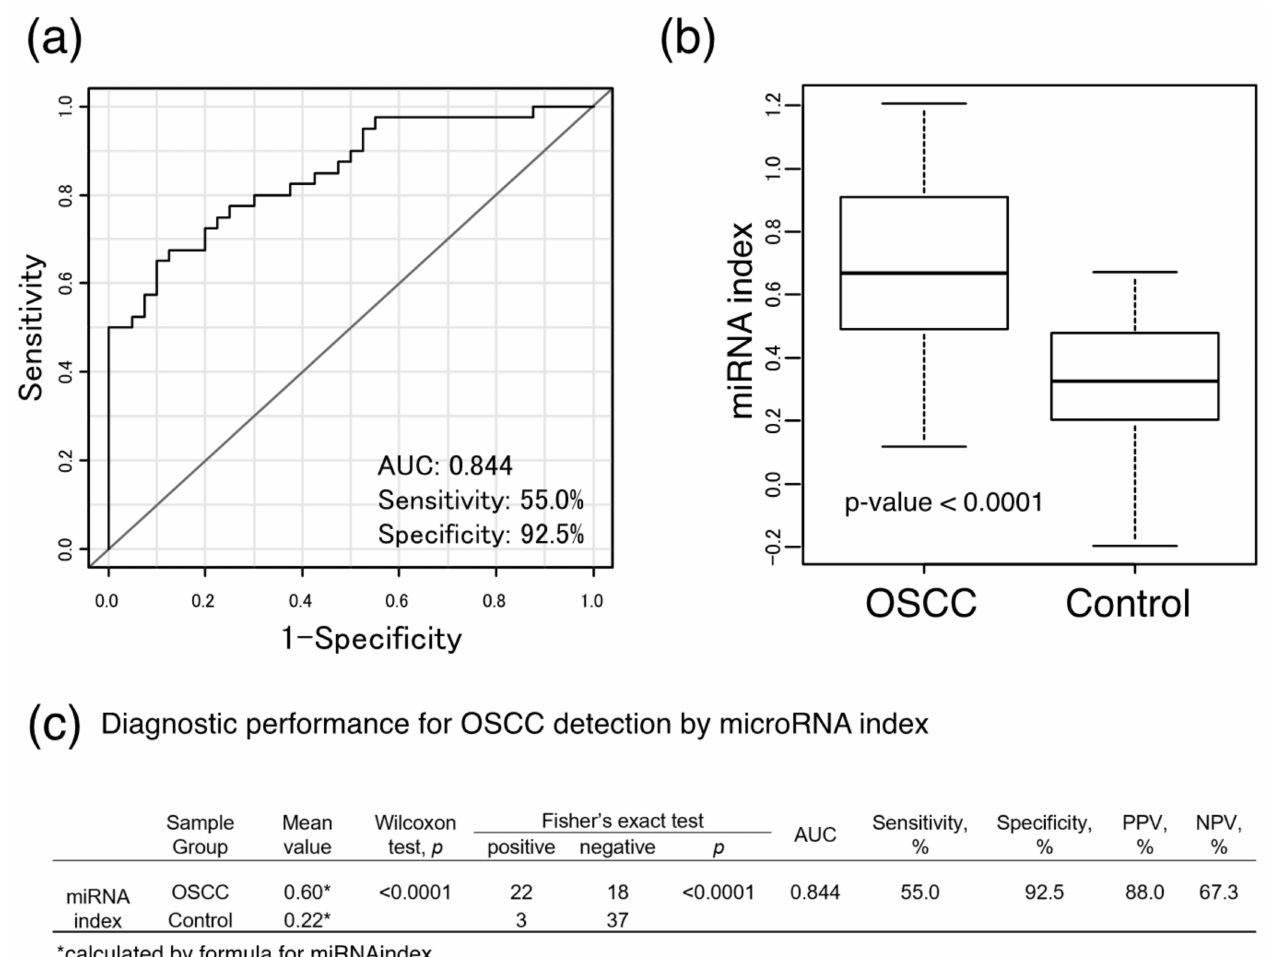
Figure 5. The diagnostic performance of the models was investigated using a combination of miRNAs. ( a ) Using the Fisher’s linear discriminant analysis, the diagnostic index (named as miRNA index) was expressed as Equation (1). ( b ) The level of the miRNA index Q-TPJ, Chen Z. in other references in the listed 10 authors were listed prior to the additional meaning. NPV is also appropriate here, which was demonstrated to be significantly higher in the oral squamous cell carcinoma (OSCC) patient group than that in the control group. ( p < 0.0001, Wilcoxon test). ( c ) Diagnostic performance for OSCC detection by the miRNA index using the cutoff